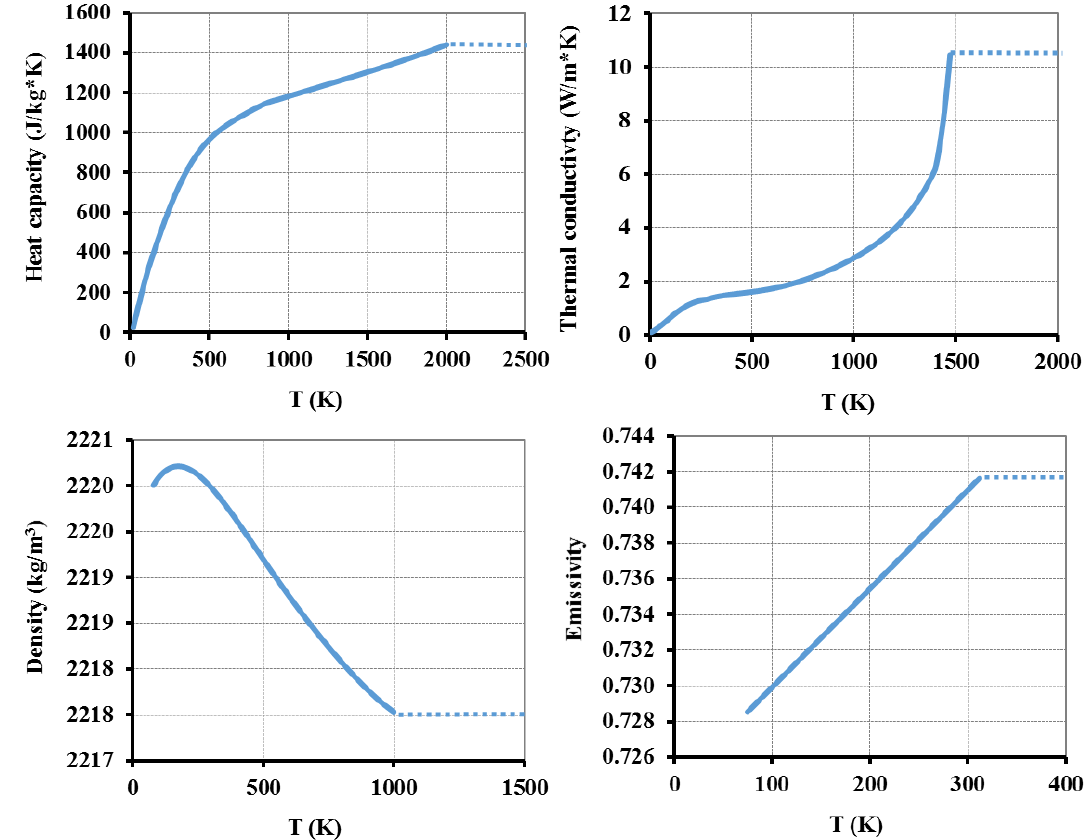
Figure 2. Variation of the main parameters used of Corning 7940 fused silica glass as defined in the COMSOL’s materials